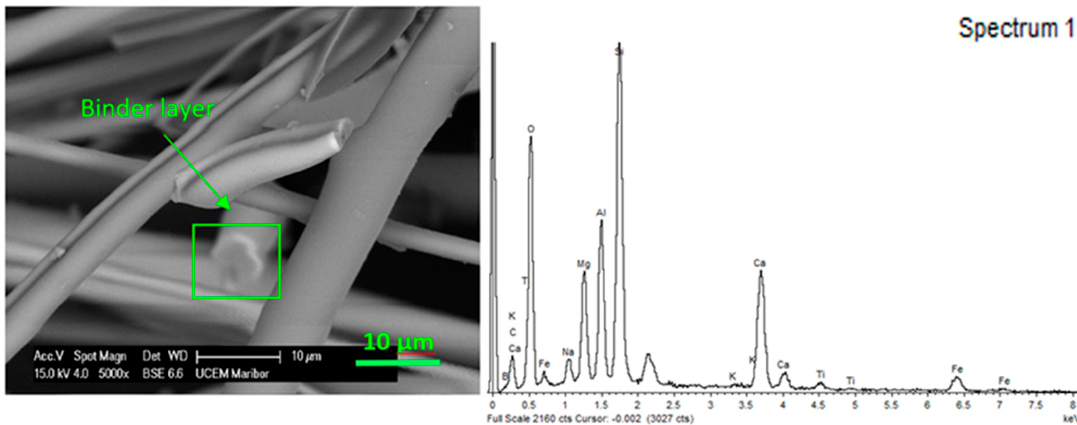
Figure 7. SEM-EDX was used to observe the composition of the surface of the new basalt wool sample coated with binder. The thick white uniform layer that surrounds the basalt fiber is the coated binder. Table 2. Surface concentration of elements in a new sample (etalon), a sample with crack defects, and a sample with bulge defects (wt.%).